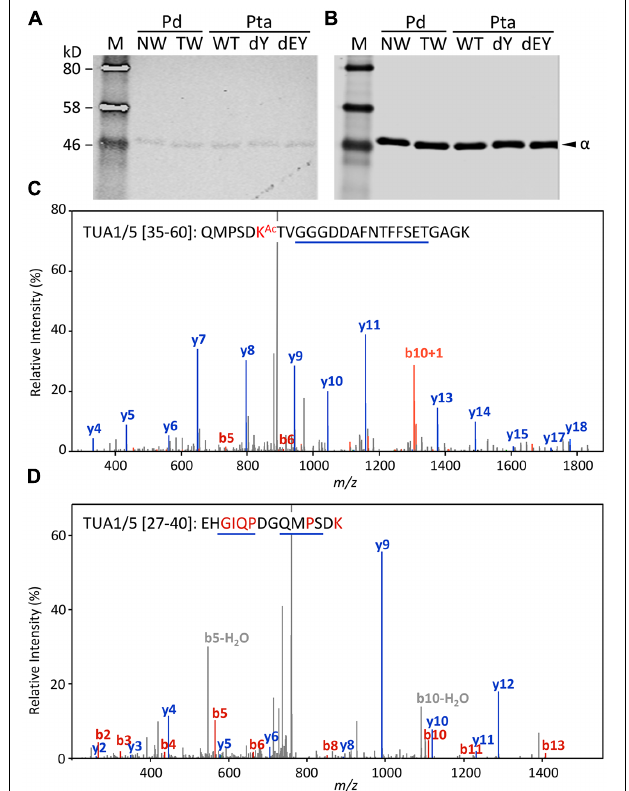
FIGURE 5 | Acetylation of TUA. (A,B) The enriched tubulins were probed with anti-acetylated TUA (A) or anti-TUA (B) antibodies. Samples are the same as in Figure 4 . (C) MS/MS spectra of a trypsin peptide shared by TUA1 and TUA5. The mass difference between b5 and b6 ions corresponds to an acetylated Lys residue. (D) MS/MS spectra of a trypsin peptide cleaved at Lys-40, shared by unmodified TUA1 and TUA5. The b ions and y ions are labeled in red and blue,